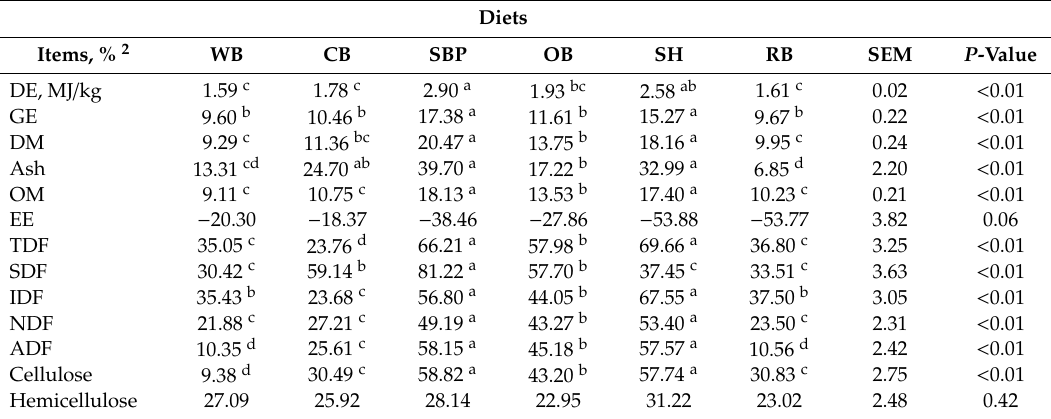
Table 5. The hindgut disappearance of chemical components in pigs fed diets with di ff erent high-fiber ingredients 1